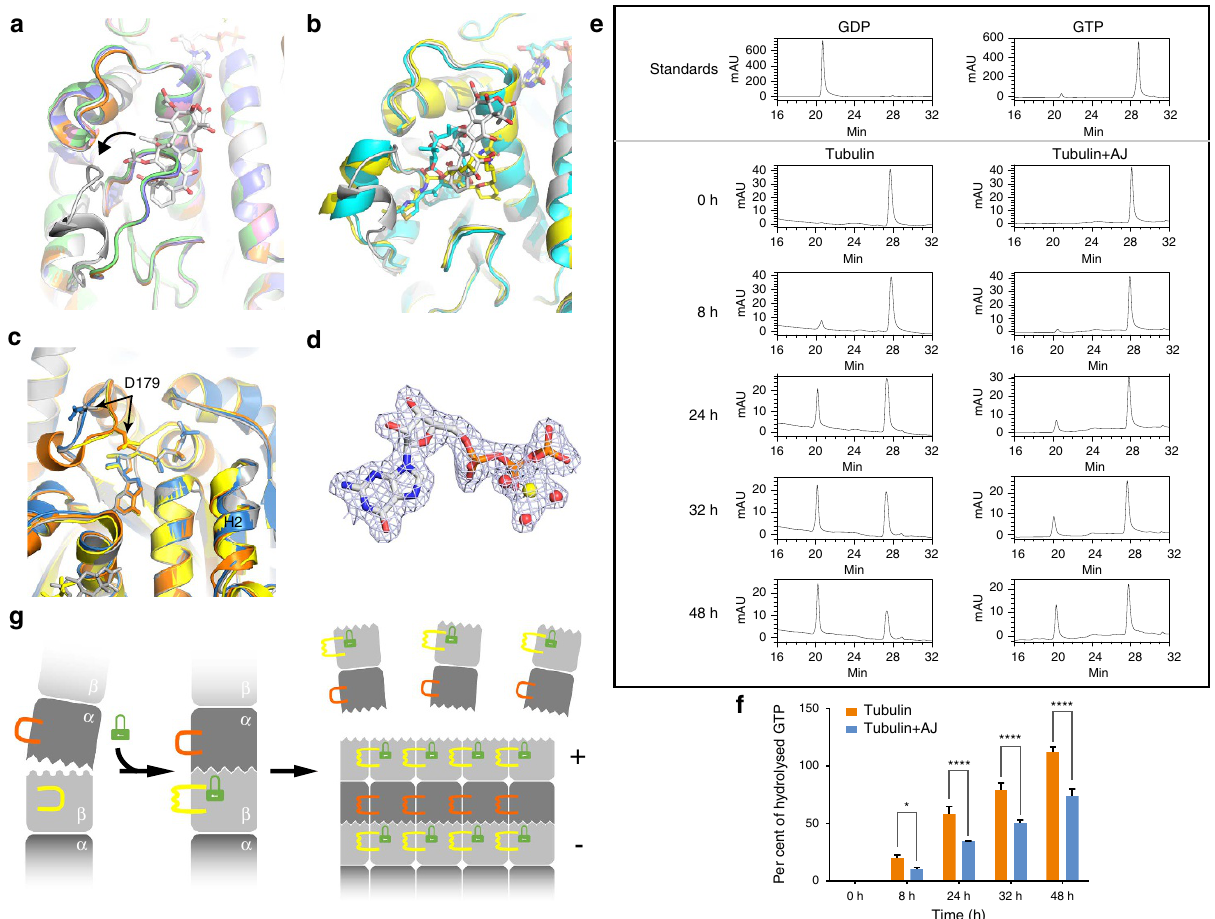
Figure 4 | The microtubule-stabilizing mechanism of AJ. ( a ) Superposition of tubulin–AJ (grey) and taxane-site-free tubulin structures (5CA0: pink; 5CA1: orange; 5C8Y: blue; 5CB4: green) shows the closed-to-open conformational change of the b M-loop. ( b ) Superposition of tubulin–MSA structures (AJ: grey; Zampa: yellow; EpoA: cyan) shows the helix conformation of the b M-loop. ( c ) Comparison of E-site conformations. The b -subunits of AJ-bound tubulin (grey), GTP-preferred status tubulin (3RYF: blue), Zampa-bound tubulin (orange) and EpoA-bound tubulin (yellow). ( d ) Electron density of GTP at the E-site in tubulin–AJ complex, with a magnesium ion (yellow) and three water molecules (red). ( e ) Reverse-phase HPLC (RP-HPLC) assay shows that AJ binding significantly delayed E-site GTP hydrolysis. ( f ) Quantification of the hydrolysis of the E-site GTP. The area of GDP and GTP peaks in e are calculated. Values are means ± s.d. ( n ¼ 3). * P o 0.05; **** P o 0.0001. ( g ) Proposed microtubule-stabilizing mechanism of AJ. Binding of AJ (green lock) to the taxane- site induces the b M-loop (yellow) to undergo a closed-to-open and loop-to-helix conformational change, and locks the E-site into a GTP-preferred conformation (sawtooth). The GDP-status conformation is shown as wave.